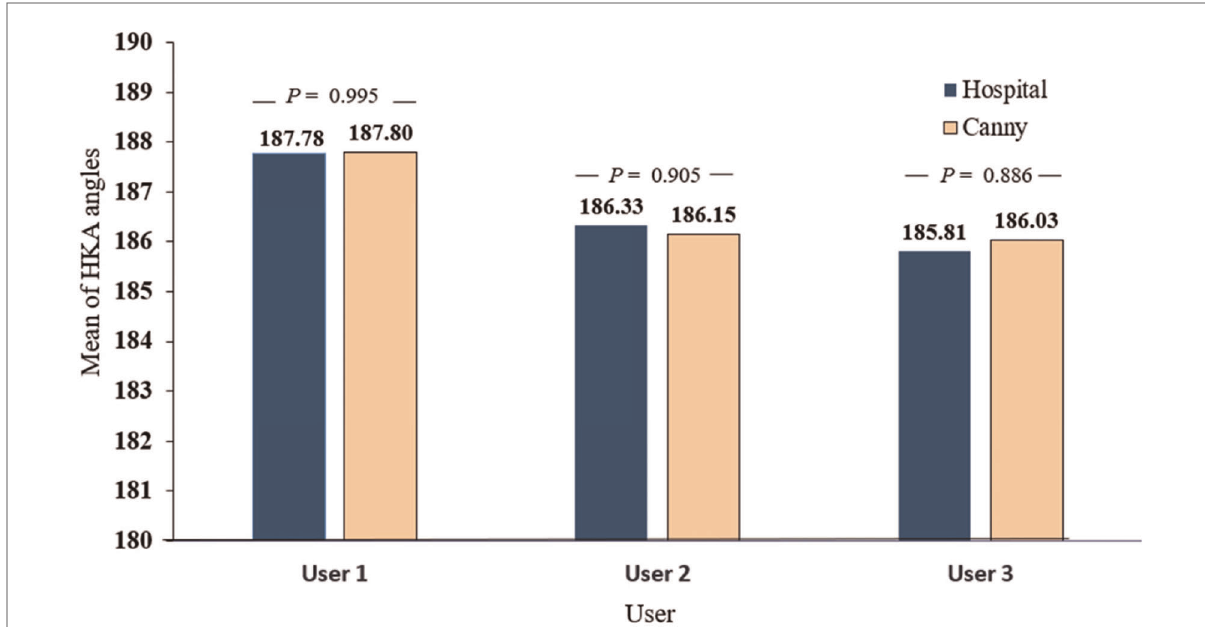
FIGURE 5 Manually measured HKA angles comparison for three different users between x-ray images stitched by an expert and acquired from the hospital and x-ray images stitched using our method based on canny